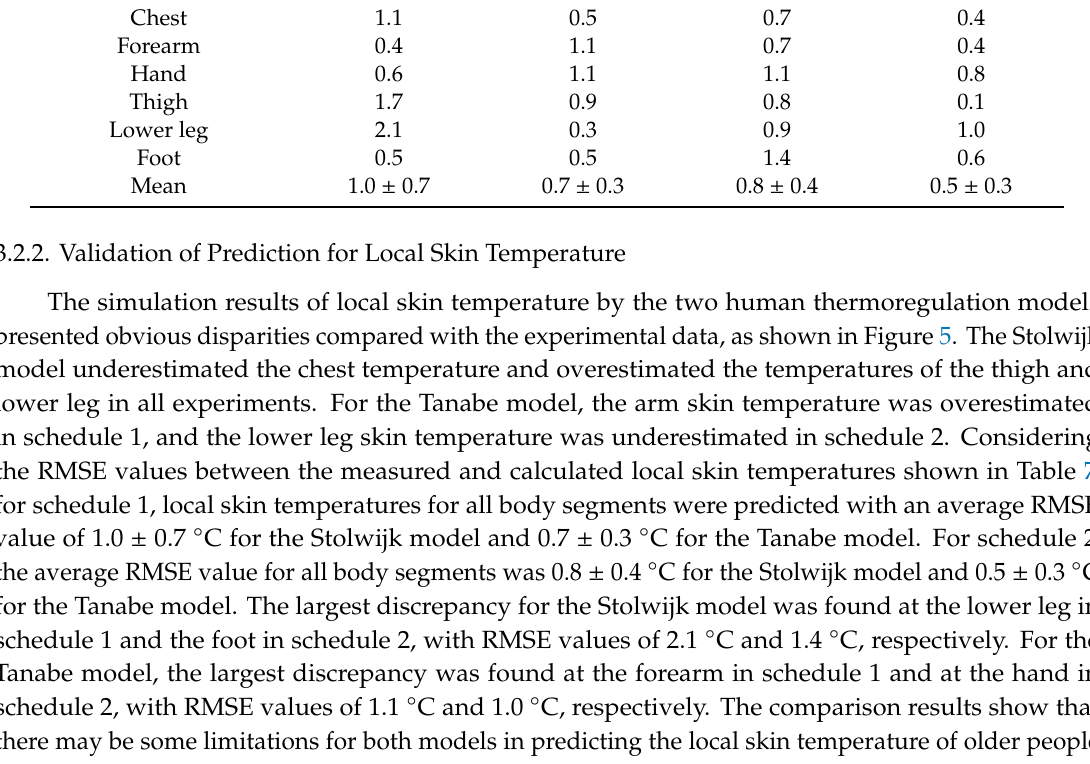
Table 7. RMSE ( ◦ C) between measured and calculated mean and local skin temperatures. Schedule 1 Schedule 2 Skin Temperature Stolwijk Model Tanabe Model Stolwijk Model Tanabe Model Mean skin temperature